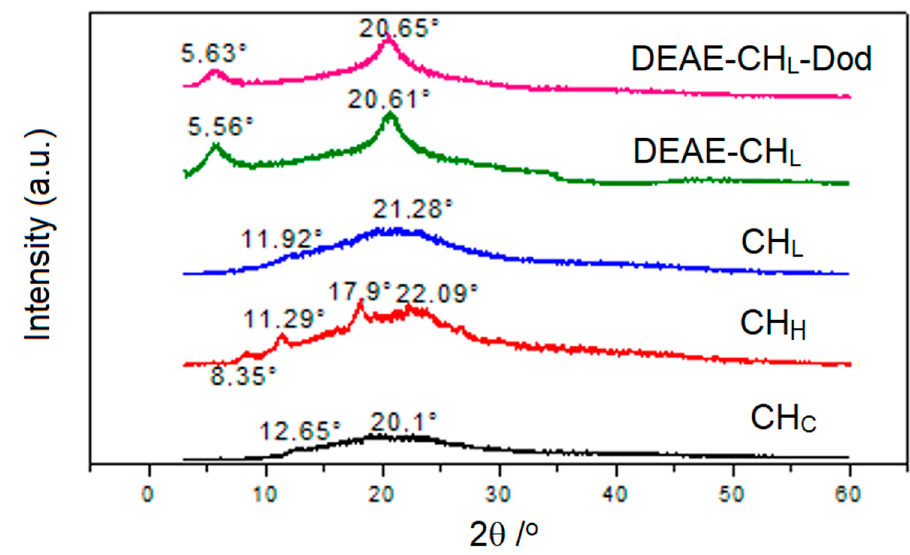
Figure 1. X-ray di ff raction for films of commercial chitosan and its Figure 1. X-ray diffraction for films of commercial chitosan and its derivatives.